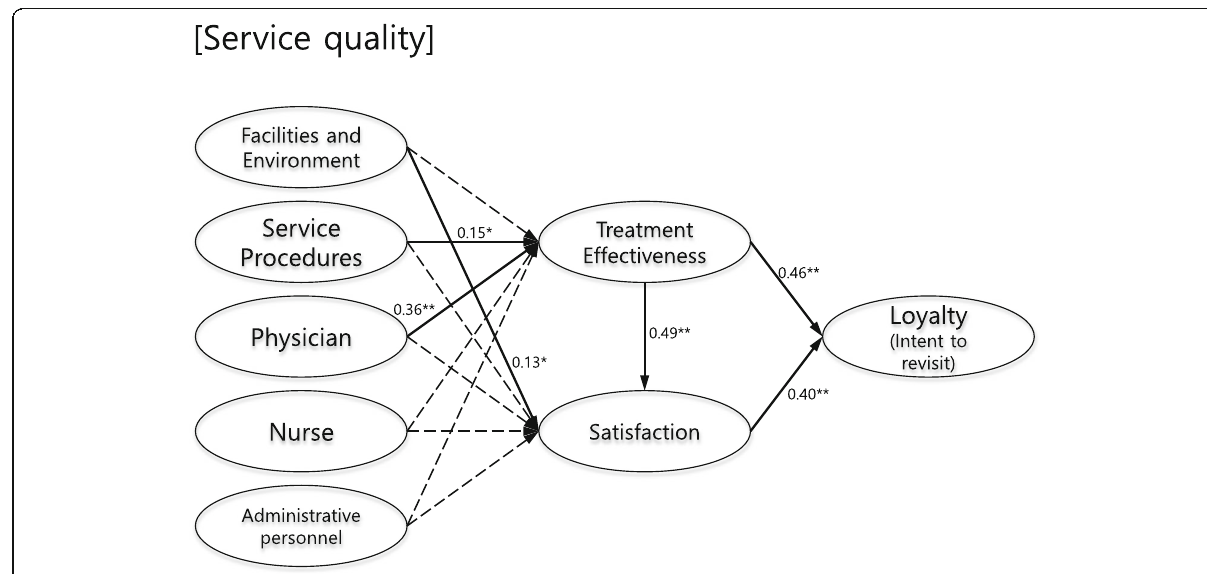
Fig. 2 Final selected structural model with path coefficients. Service quality = facilities and environment, service procedures, physician, nurse, and administrative